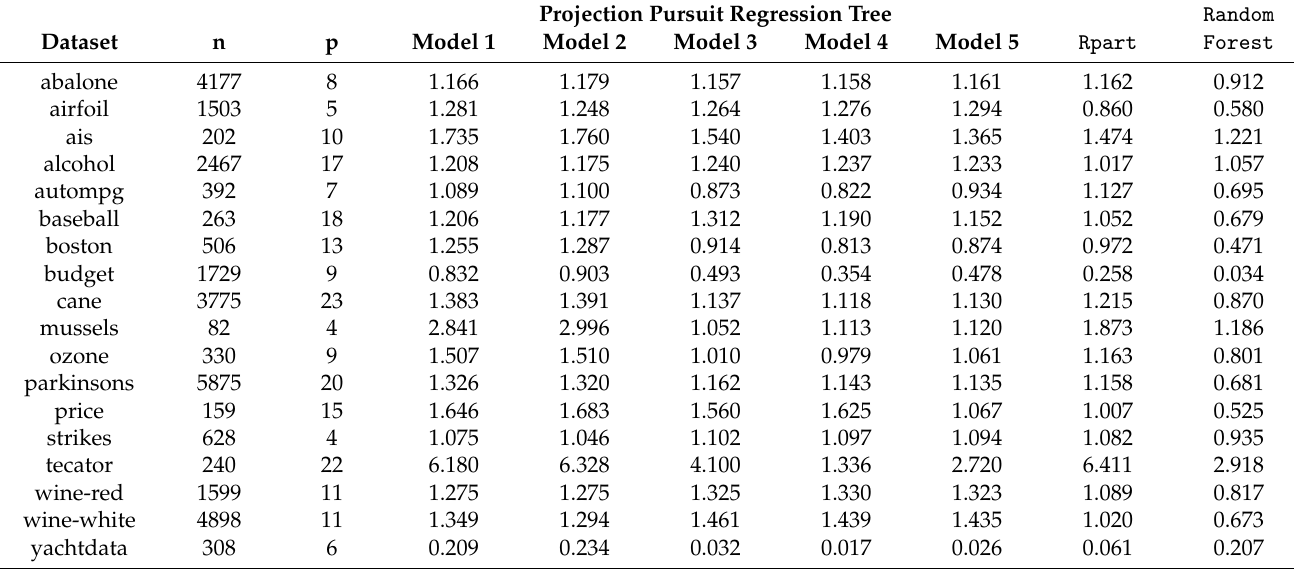
Table 8. Comparison of lm , rpart , randomForest , and the projection pursuit regression tree with various data sets; the mean MSE/MSE( lm )of 200 iterations for the test